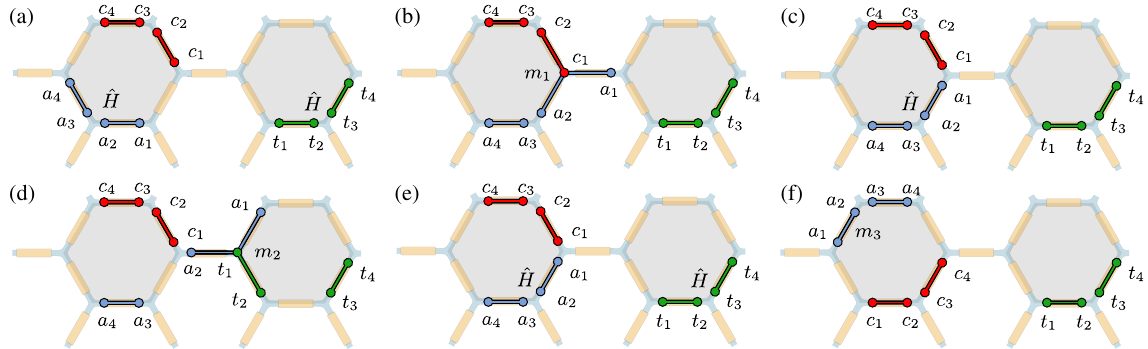
FIG. 5. Protocol for a CNOT between two adjacent hexagonal-cell qubits using the quantum circuit in Fig. 4. In the cell occupied by the control qubit (red), an ancilla (blue) is initialized in the j 0 i state and moved to the double T junction of the cell. (a) The ancilla and target (green) are rotated via a Hadamard gate. (b) The first two Majoranas of the control, c 1 and c 2 and ancilla a 1 and a 2 are moved onto a connected island, and the four-Majorana fermion parity − a 1 a 2 c 1 c 2 is measured, corresponding to a two-qubit parity measurement σ ⊗ σ with outcome m 1 . (c) The ancilla is moved back to the double T junction for another H gate. (d) The ancilla and target parity m 2 z z is measured via a four-Majorana parity measurement in the right cell. (e) An H gate is applied to the ancilla and target qubits in their respective double T junctions. (f) Finally, all qubits return to their initial positions, and the ancilla qubit is measured by measuring the two-Majorana fermion parity ia 1 a 2 with outcome m 3